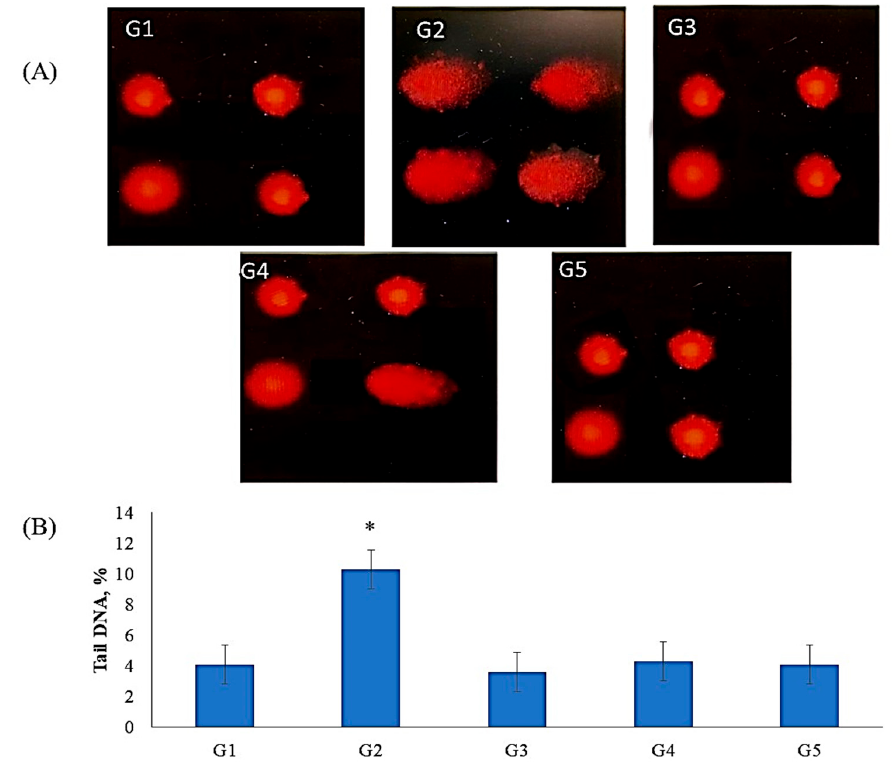
Figure 3. The ameliorating effect of Nano-CUR on genotoxicity induced by TZ-ingested rats: ( A ) Fluorescence micrograph of bone marrow cells nuclei after the comet assay. The untreated rats (G1) (control) show no detectable DNA damage. The nuclei of TZ-ingested rats (G2*) appeared damaged. The nuclei of Nano-CUR ingested rats (G3) appeared to have no detectable DNA damage as control. The nuclei of (1 g Nano-CUR + 7.5 mg TZ-mix)-ingested rats appeared to have slight damage, the nuclei of (2 g Nano-CUR + 7.5 mg TZ-mix)-ingested rats appeared to have no detectable DNA damage. ( B ) Bar graph showing the tail DNA damage percentage in nuclei of bone marrow of all treated rats subjected to comet assay. Data are mean ± S.D. ( n = 10, p < 0.05).